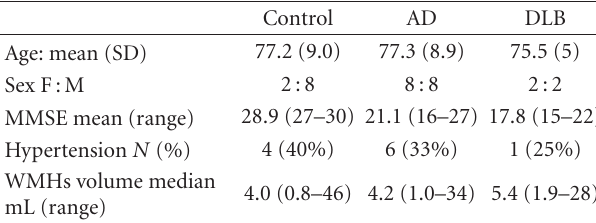
Table 1: Subject demographic details. WMHs volume is from man- ual